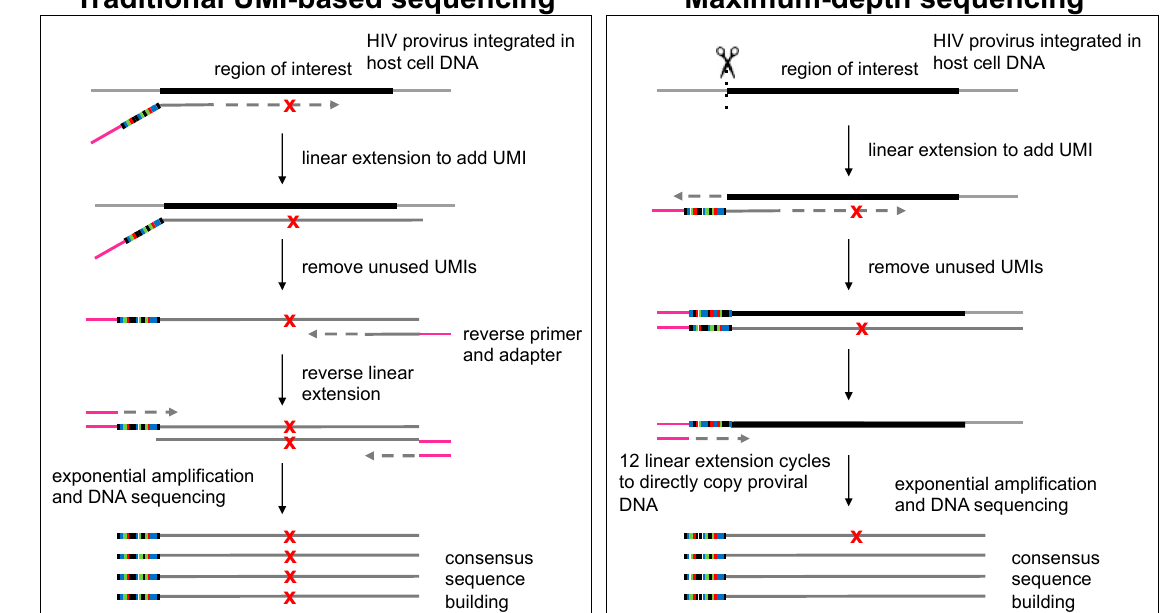
Figure 1. Schematic representations of traditional UMI-based sequencing and MDS. In traditional UMI-based sequencing, an initial linear round of PCR is used to copy the starting template and add a UMI. During this step, errors may occur at a low frequency dependent on the intrinsic error rate of the polymerase used, denoted by X. Exponential amplification from the tagged molecule results in the fixation of these errors within the read family, which then register as true virological mutations in the consensus sequence. In MDS, however, samples undergo an initial restriction enzyme digestion with a sequence-specific enzyme adjacent to the ROI, resulting in a 3 ′ -OH overhang. A single round of linear amplification is performed which results in the addition of a UMI and the Illumina adapter to the sticky end of the gDNA molecule. The tagged gDNA molecule serves as the template for further rounds of amplification. Therefore, while polymerase errors may still appear in some reads, amplification occurs preferentially from the tagged starting gDNA molecule, such that reads with errors remain a minority of the read family and the consensus sequence remains a more accurate representation of the original starting template.